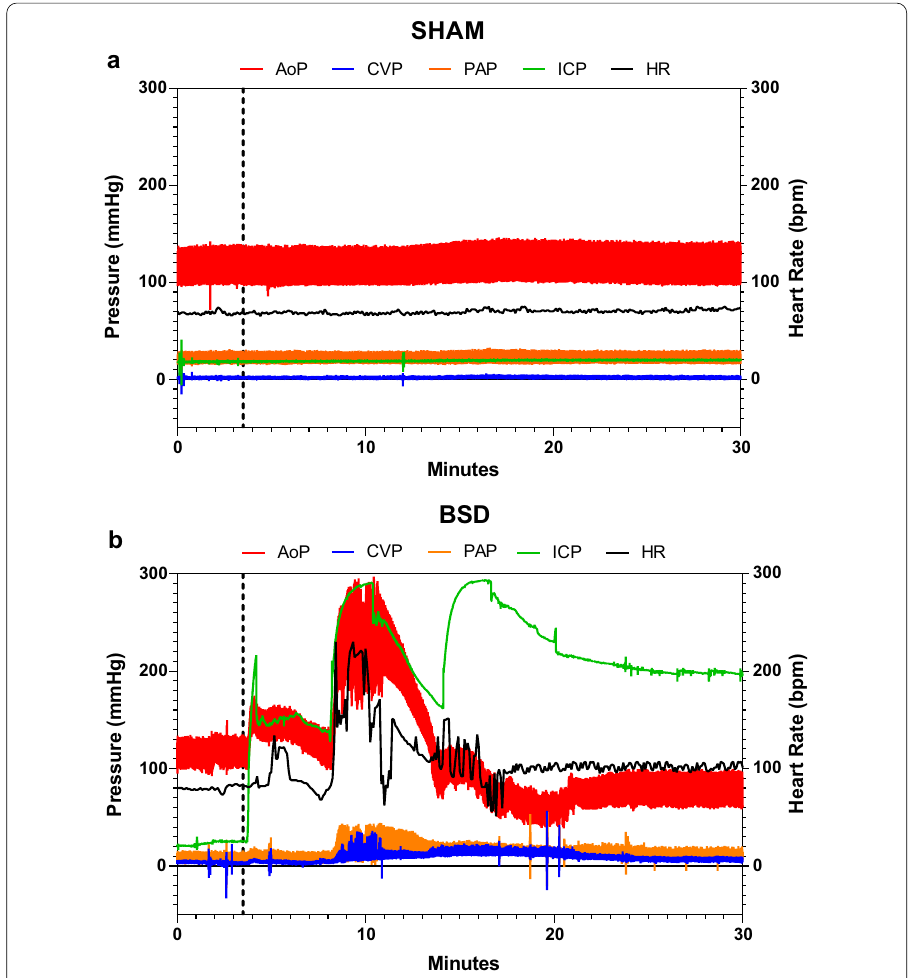
Fig. 2 Representative hemodynamic changes during BSD induction (before confirmation of BSD). Changes in aortic pressure (AoP), central venous pressure (CVP), pulmonary artery pressure (PAP), intracranial pressure (ICP) and heart rate (HR) in sham ( a ) and BSD donors ( b ) during BSD/sham induction. Dotted line in a represents beginning time‑matched rest for sham donors, and commencement of Foley catheter inflation